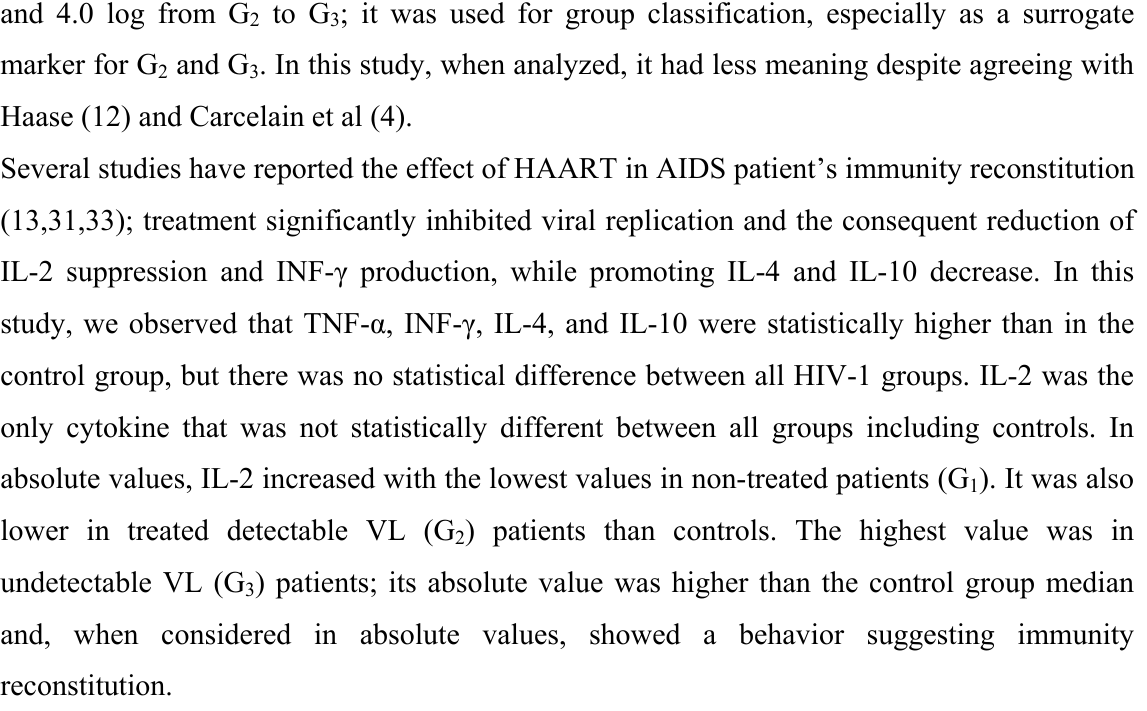
D. A. Meira et al . CORRELATION BETWEEN CYTOKINE SERUM LEVELS, NUMBER OF CD4 + T CELLS/mm³ AND VIRAL LOAD IN HIV-1 INFECTED INDIVIDUALS WITH OR WITHOUT ANTIRETROVIRAL THERAPY.